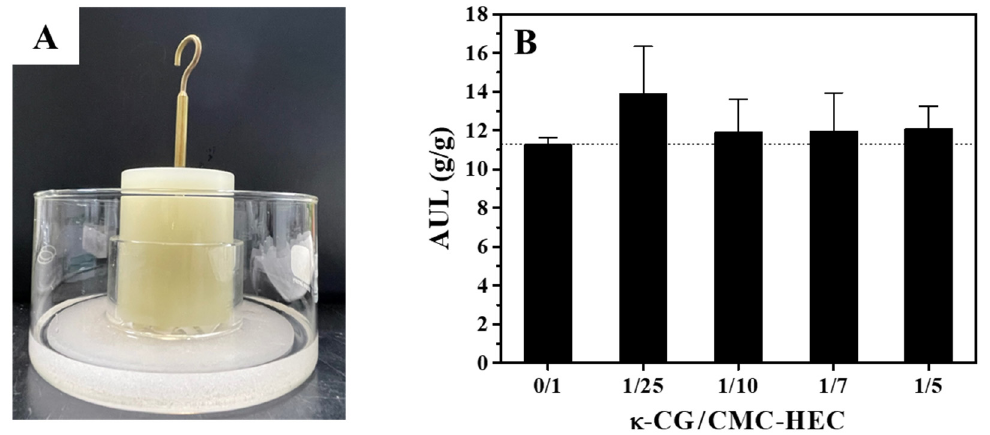
Table 3. Kinetic ‐ model parameters obtained using the nonlinear PFO and PSO models for the water absorption onto the dried gels in deionized water (pH 7) at 25 °C. Figure 9. (A) Photographs of the AUL test equipment. (B) Effects of the κ‐ CG content on the AUL Figure 9. ( A ) Photographs of the AUL test equipment. ( B ) Effects of the κ -CG content on the AUL of of the dried gel particles in deionized water (pH 7) at 25 °C. the dried gel particles in deionized water (pH 7) at 25 ◦